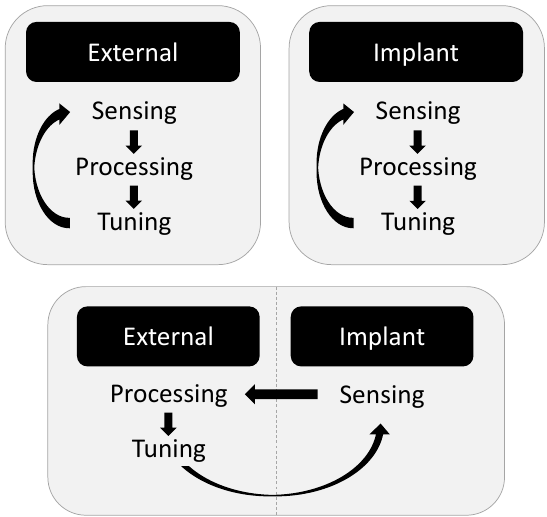
Figure 4. Existing approaches to adaptive transcutaneous system